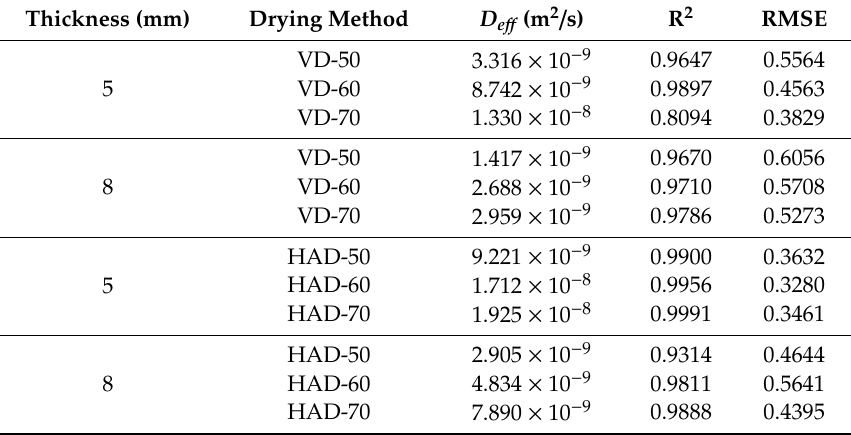
Table 2. Values for e ff ective moisture di ff usivity, D e ff